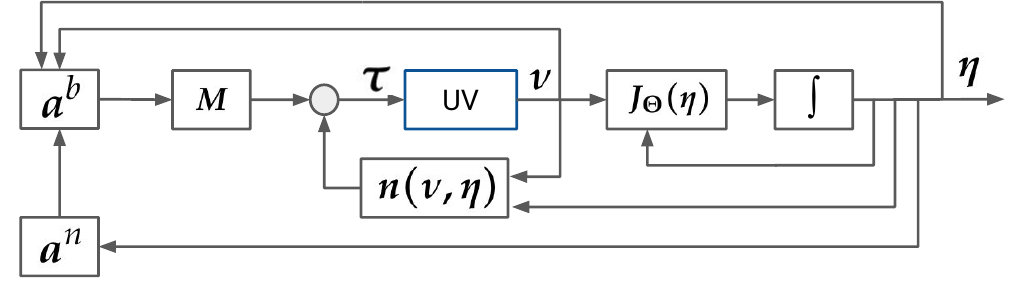
Figure 7. Feedback Linearization control block diagram with nonlinear decoupling in NED frame and transformation to the Body